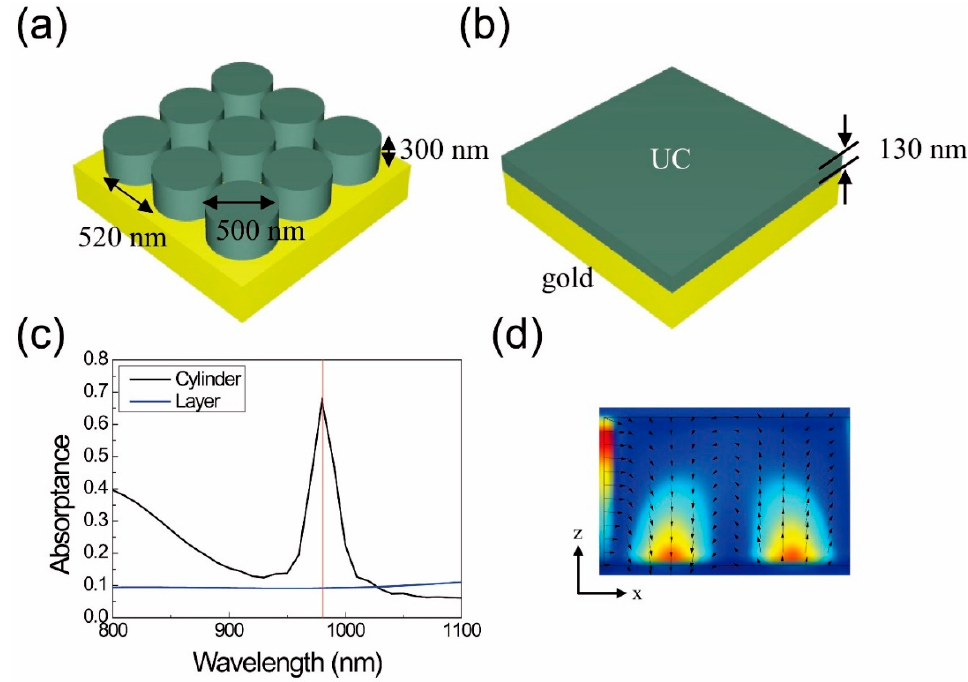
Figure 4. ( a ) Schematic of the proposed UC nanocylinder array structure with a gold substrate. Here, the UC cylinders have a height of 300 nm and a diameter of 500 nm. The period in the array is 520 nm; ( b ) Reference structure consisting of a UC film with a thickness of 130 nm and a gold substrate. The thickness is determined to have the same UC volume as the proposed nanocylinder array; ( c ) The absorptances of the proposed structure (black) and reference structure (blue) as functions of wavelength. The absorptance of a cylinder array is 67.1% at 980 nm; ( d ) The electric field intensity profile with a vector field plot of the UC cylinder array.